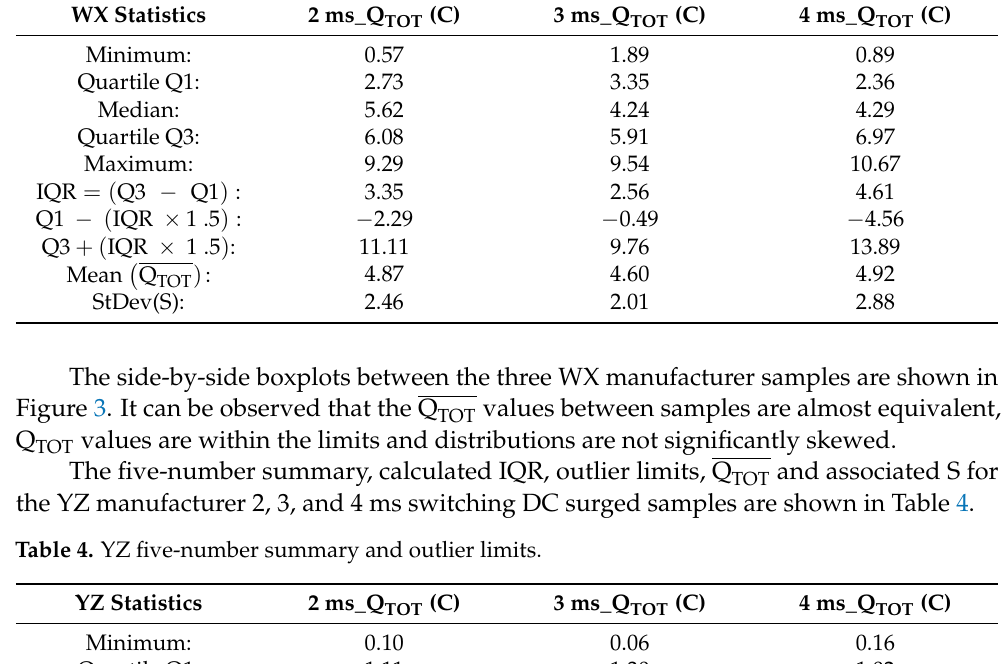
Table 3. WX five-number summary and outlier limits.